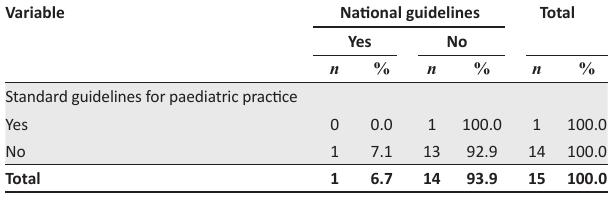
TABLE 1: The percentages of eye health practitioners who reported standard guidelines for paediatric practice n ( % ) in relation to national guidelines for referring children.